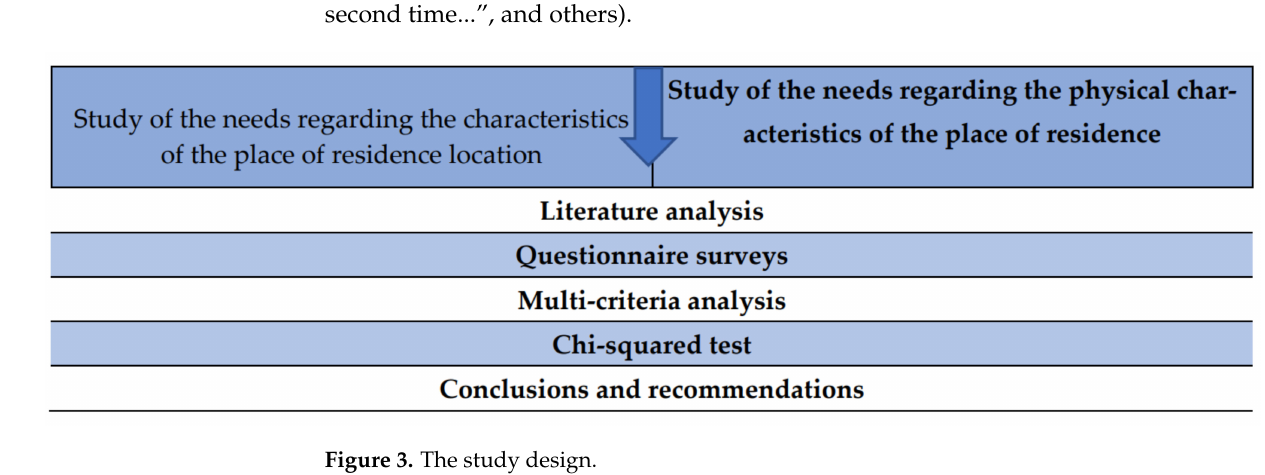
Figure 3. The study design.